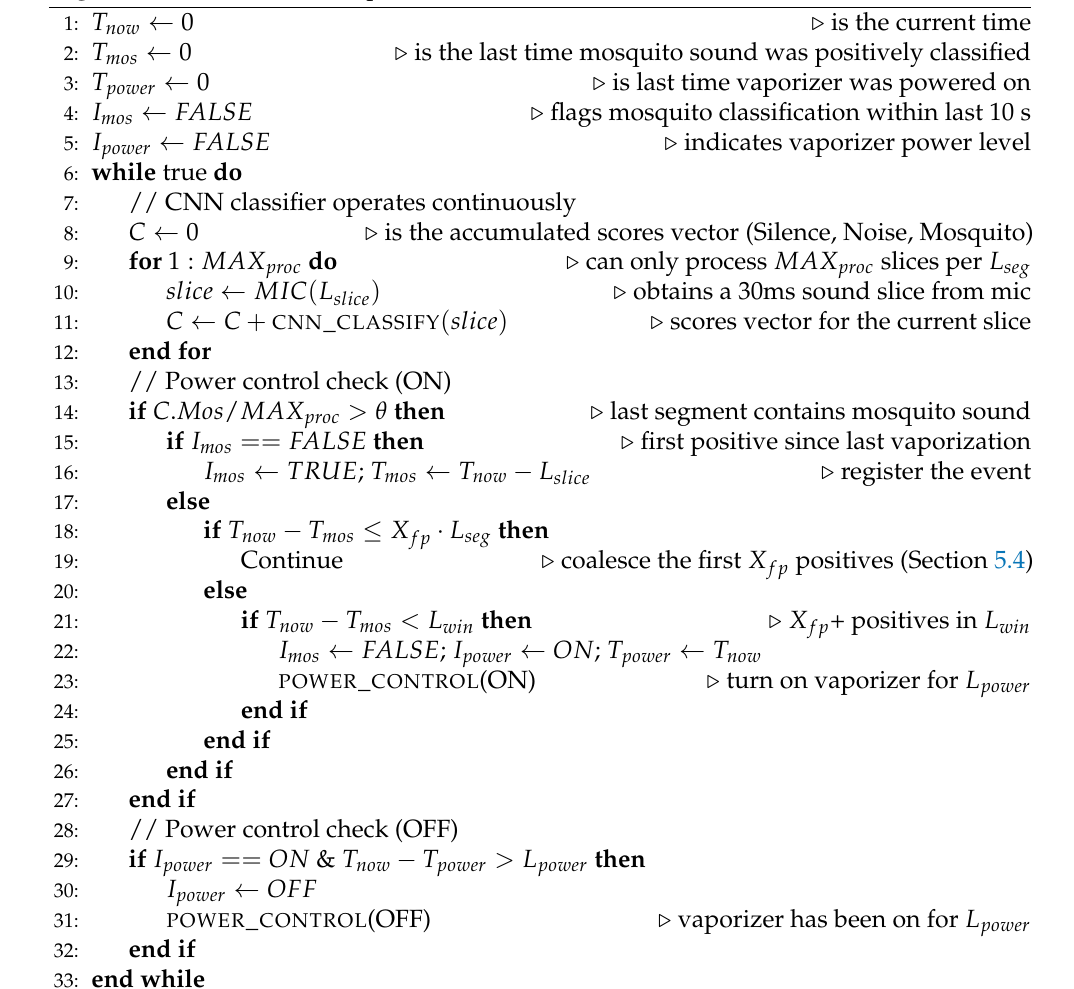
Algorithm 1 Power control